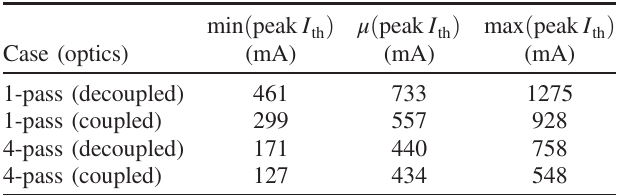
TABLE II. Summary of the peak I statistics with varying th transverse optics over 100 different HOM-assignments for the CBETA 1-pass and 4-pass mode. For both modes, introducing additional phase advances (decoupled optics) gives greater potential to increase I than x-y th